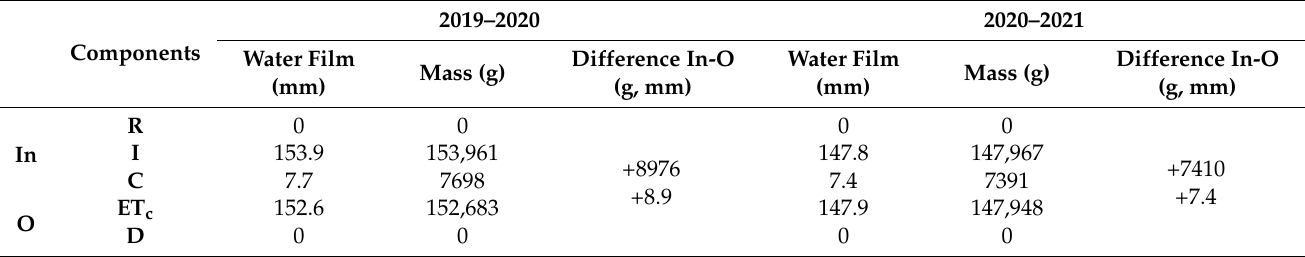
Table 5. Results for the water balance generated from the smart weighing lysimeter.